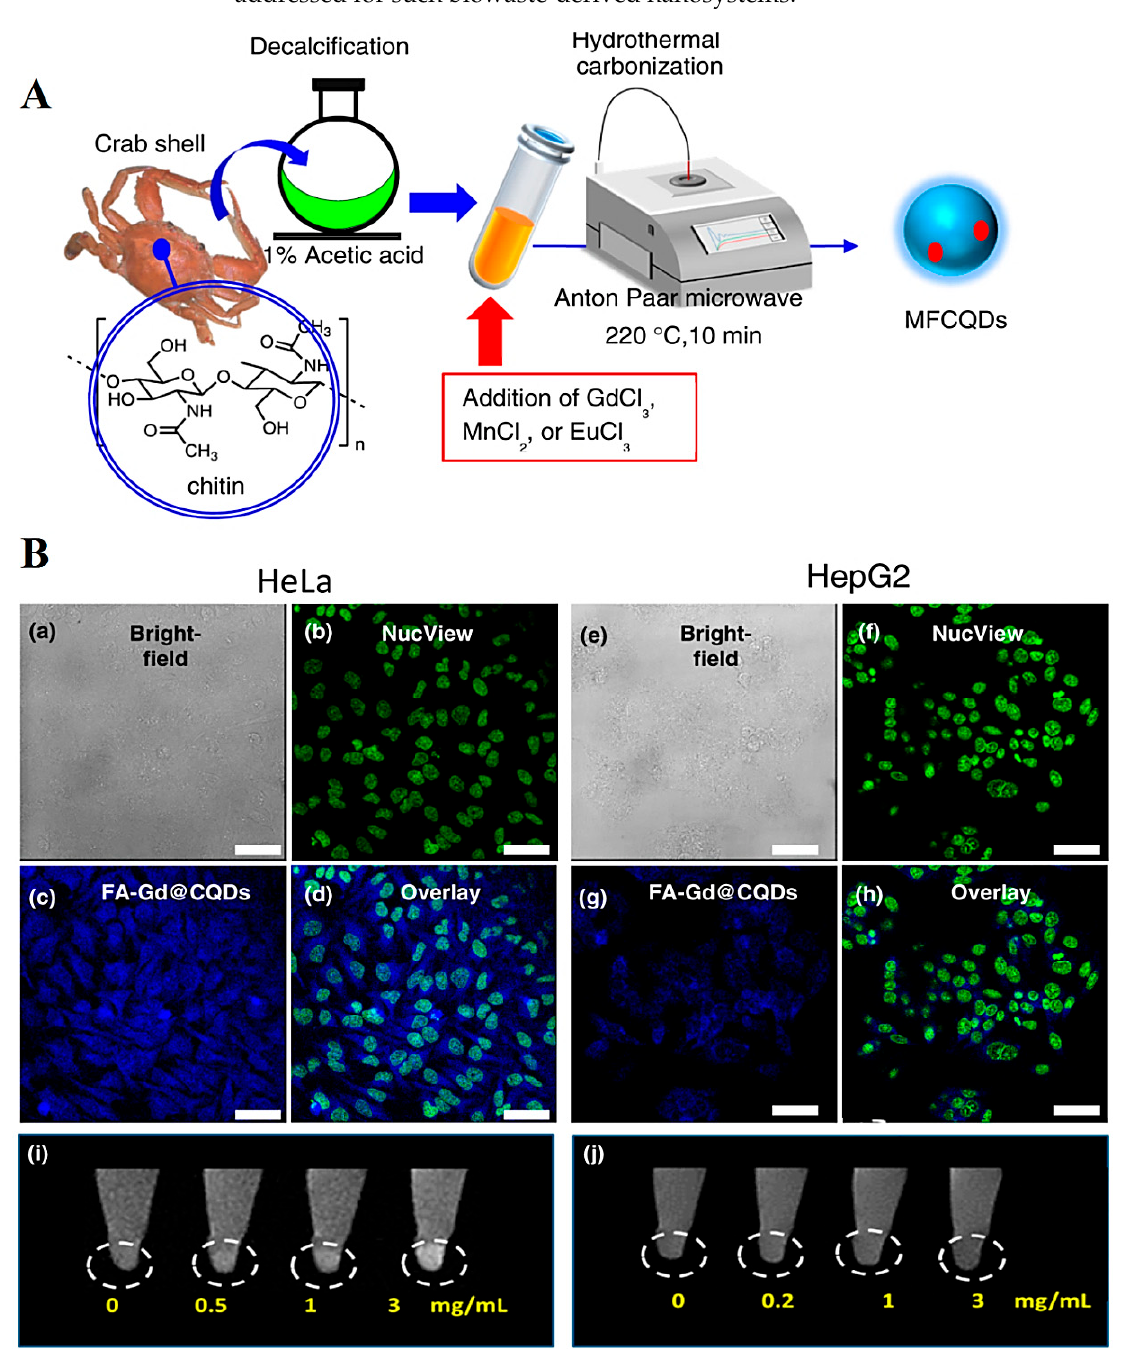
Figure 3. ( A ) The preparative process of magnetofluorescent CQDs through a microwave-assisted hydrothermal technique. ( B ) Fluorescence images of ( a – d ) HeLa and ( e – h ) HepG2 cells incubated with folic acid (FA)–Gd@CQDs (Scale bars = 40 µ m). T 1 -weighted ( i ) HeLa and ( j ) HepG2 cellular